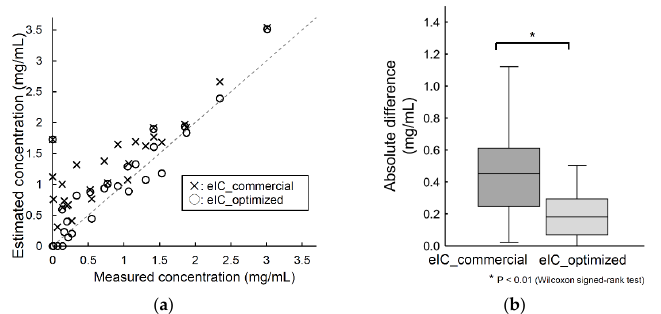
Figure 3. Distribution of computed tomography (CT) values in choroidal malignant melanoma before contrast enhancement. A strong linear correlation was found between the 80- and 140-kVp CT values. The iodine concentration can be estimated adequately from post-contrast-enhanced dual-energy CT using this correlation.